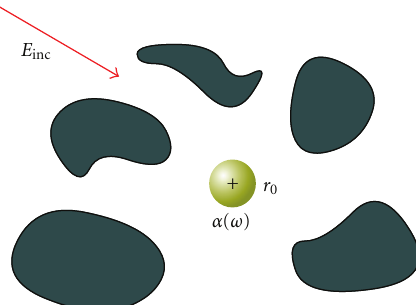
Figure 1: Optical dipole antenna of arbitrary shape in a structured environment. A point r 0 inside the antenna is used to define its